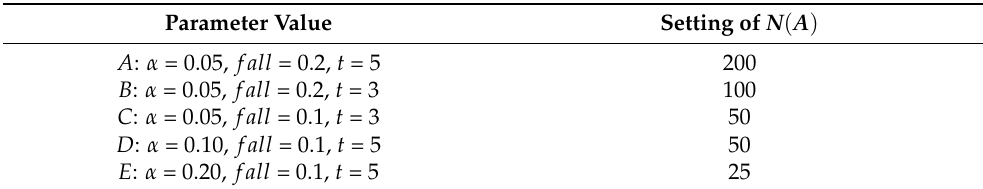
Table 2. The number of iterations required for the convergence of the model when the data update time is always earlier than the set period ( 𝑇 = 7 ).